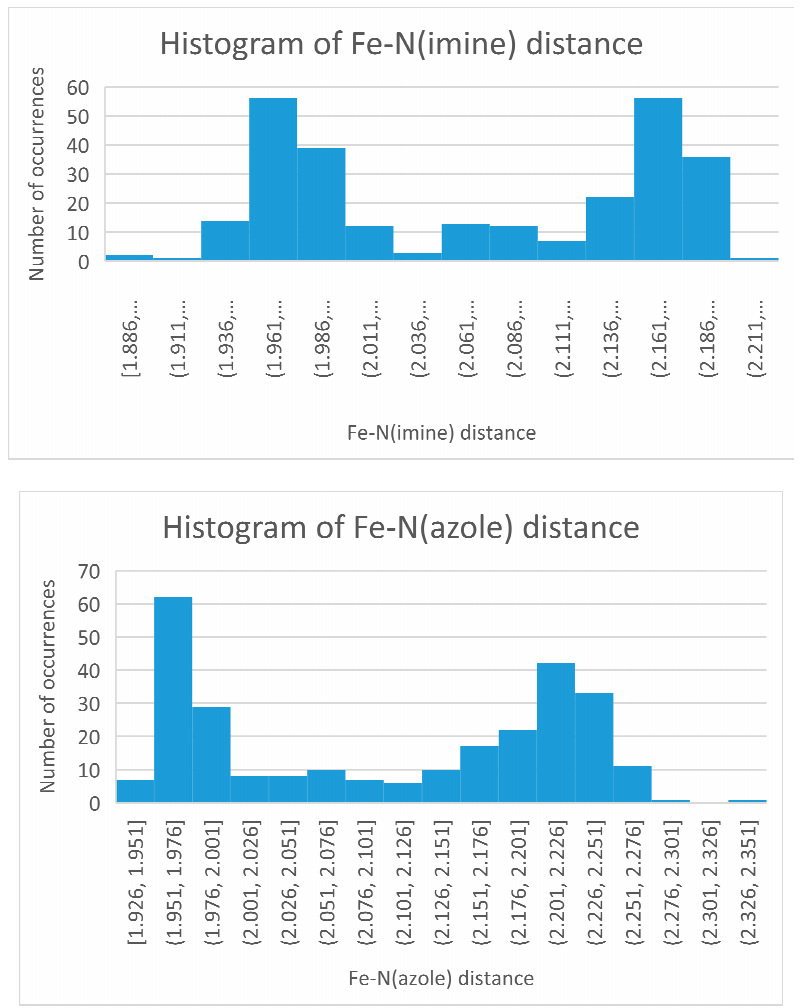
Figure 6. Histogram of the Fe(II)-N imine bond distance (top) and Fe(II)-N azole bond distance (bottom) of the 83 cationic compounds of a Schiff base (SB) of tren condensed with a 5 membered azole carboxaldehyde. Note the bimodal distribution.